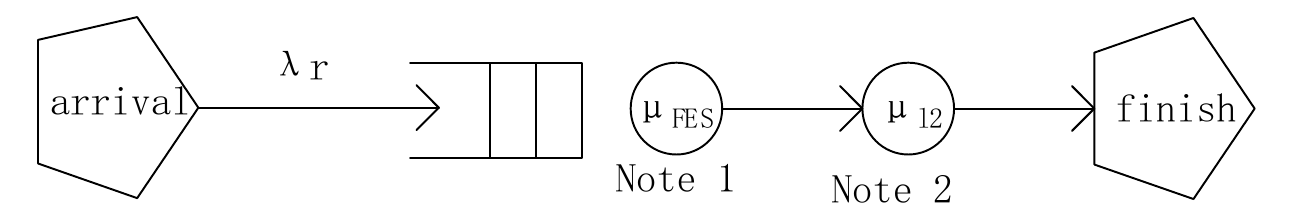
Figure 5. Open-loop queuing network using the parallel strategy .